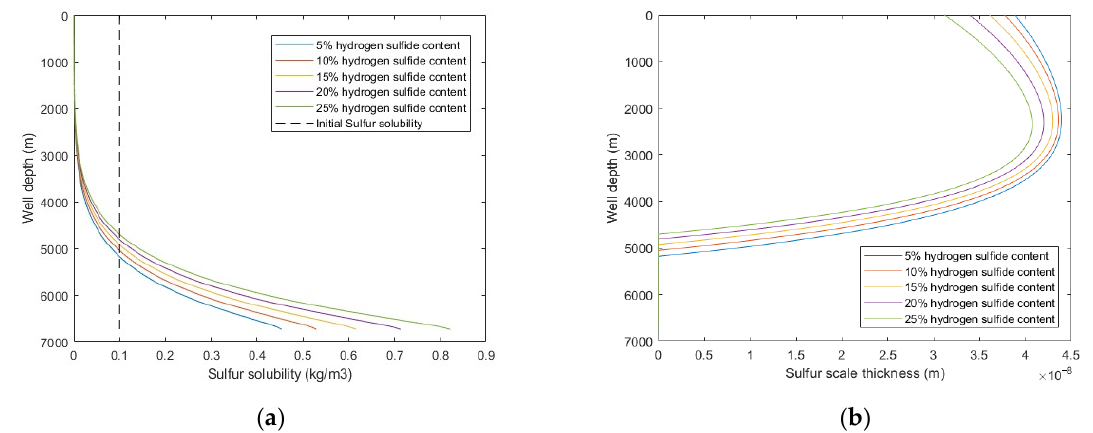
Figure 12. Calculated results with: ( a ) sulfur solubility distribution at different H 2 S content; ( b ) sulfur scale thickness distribution at different H 2 S content.